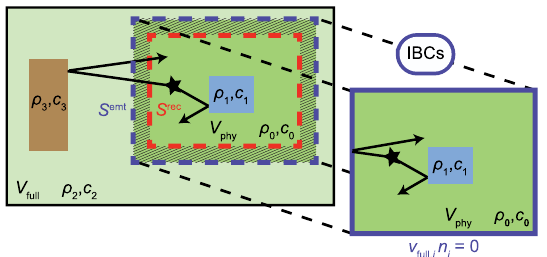
FIG. 1. Schematic of the physical (right) and the full (left) domains introduced in the IBC method with acoustic medium parameters ρ (mass density) and c (wave propagation velocity). The medium parameters need to be identical in the common region between S rec and S emt (shaded area); everywhere else they may differ. The solid blue line (right) represents a rigid boundary, while the dashed blue line (left) depicts a transparent boundary at S emt